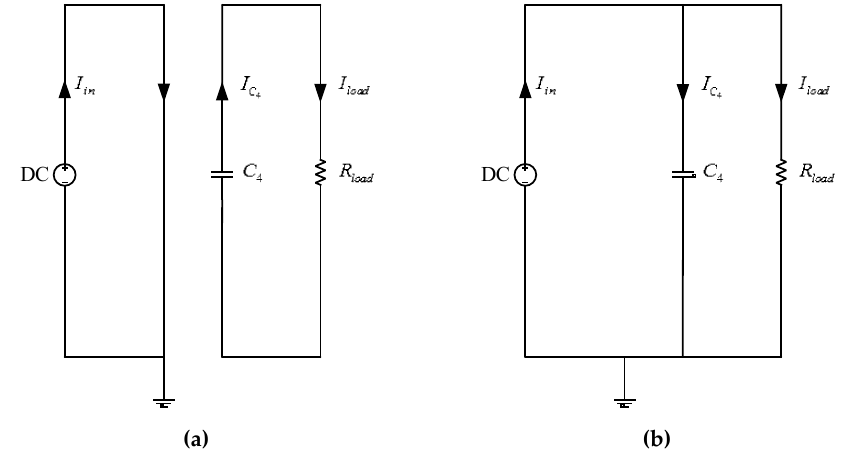
Figure 9. Schematic diagram of the equivalent circuit of the working status of the DC constant voltage conversion circuit: (a) Equivalent circuit of closed status; (b) equivalent circuit of open status. ( t ) and u ( t ) are current and voltage on capacitor C ( t ) is the Where, i C C 4 4 respectively; and i load 4 equivalent output current of DC constant voltage conversion